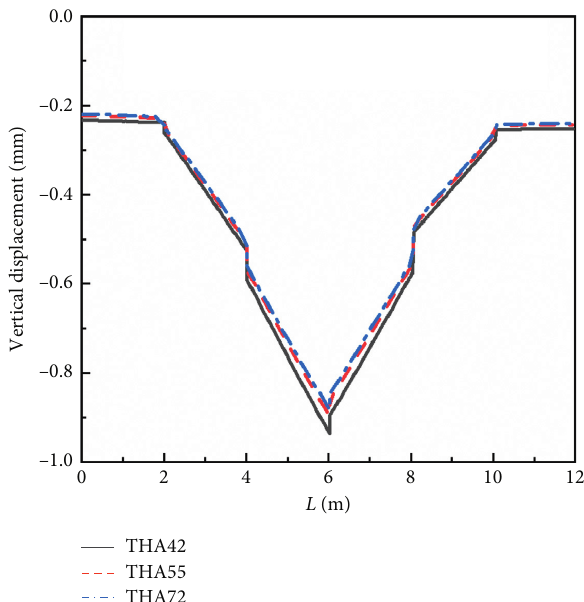
Figure 18: Longitudinal vertical displacement of the crown.